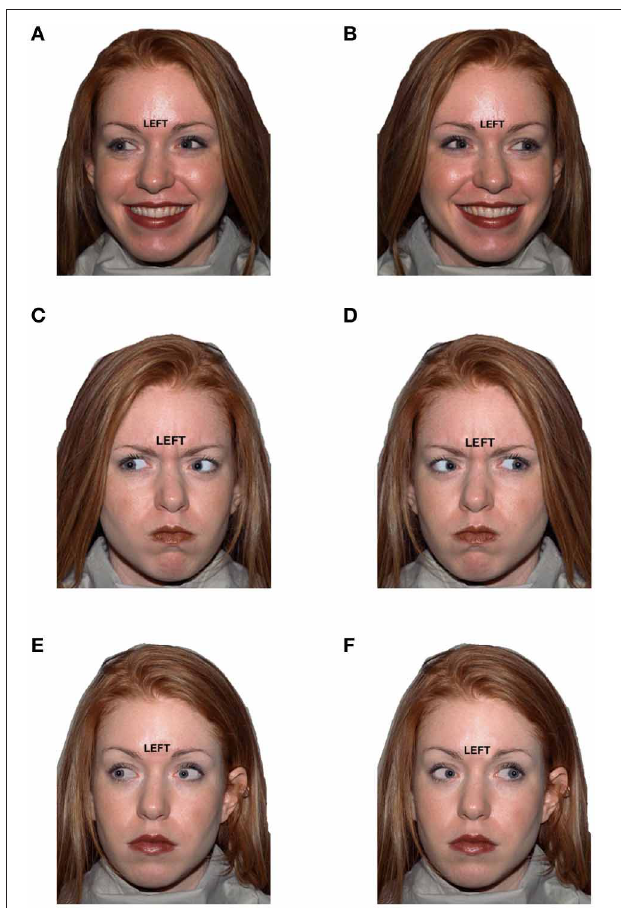
FIGURE 1 | Example stimuli for six conditions that varied by target direction to eye gaze (distractor) congruency and by emotional expression valence: (A) Happy/Congruent, (B) Happy/Incongruent, (C) Angry/Congruent, (D) Angry/Incongruent, (E) Neutral/Congruent, (F)